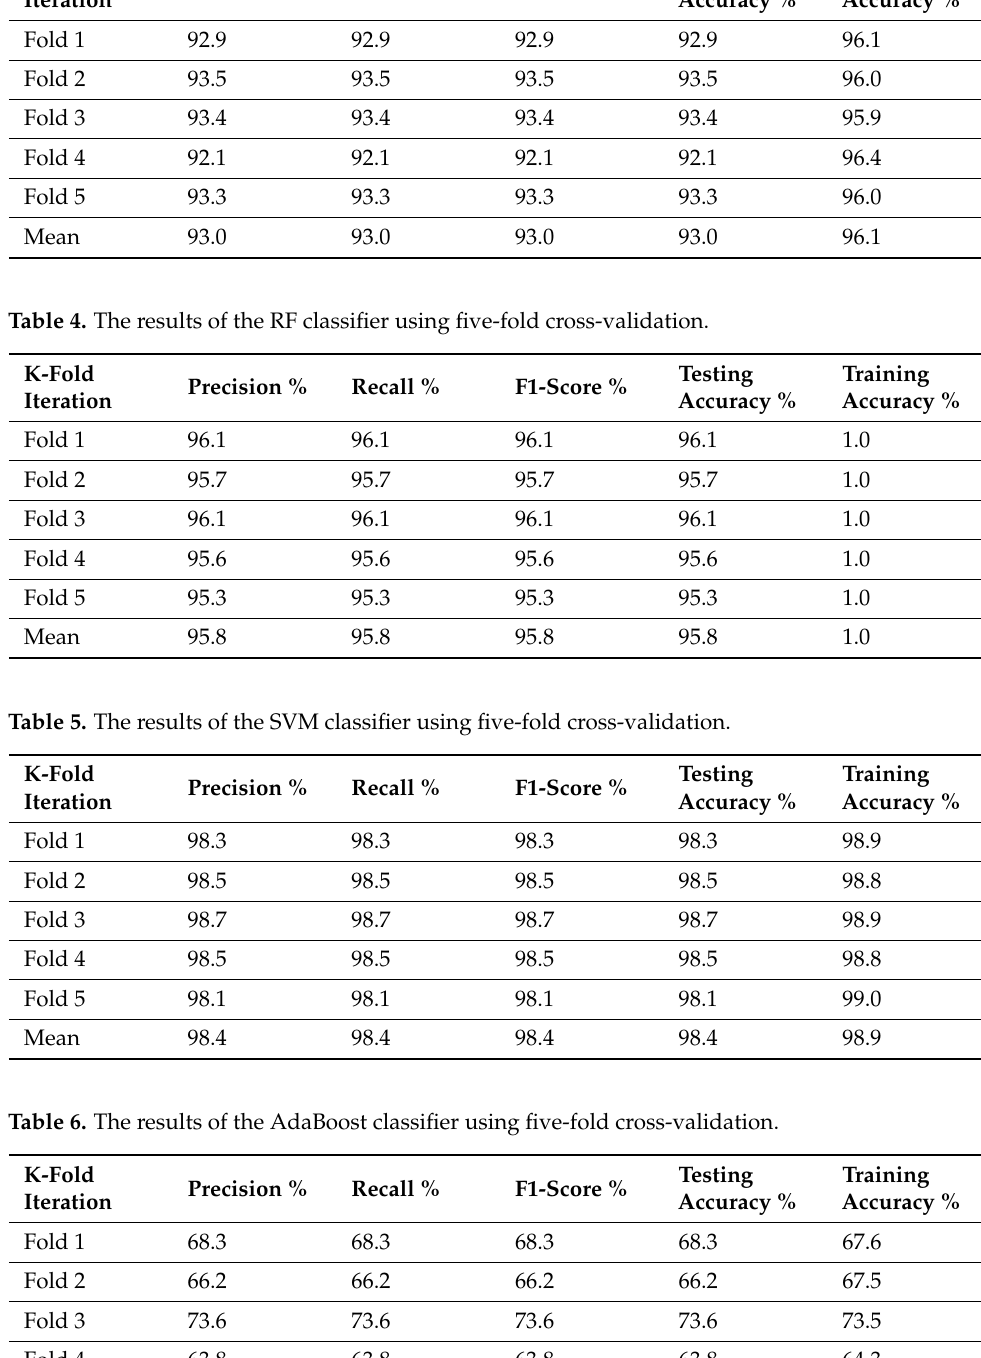
Table 3. The results of KNN classifier using five-fold cross-validation. K-Fold